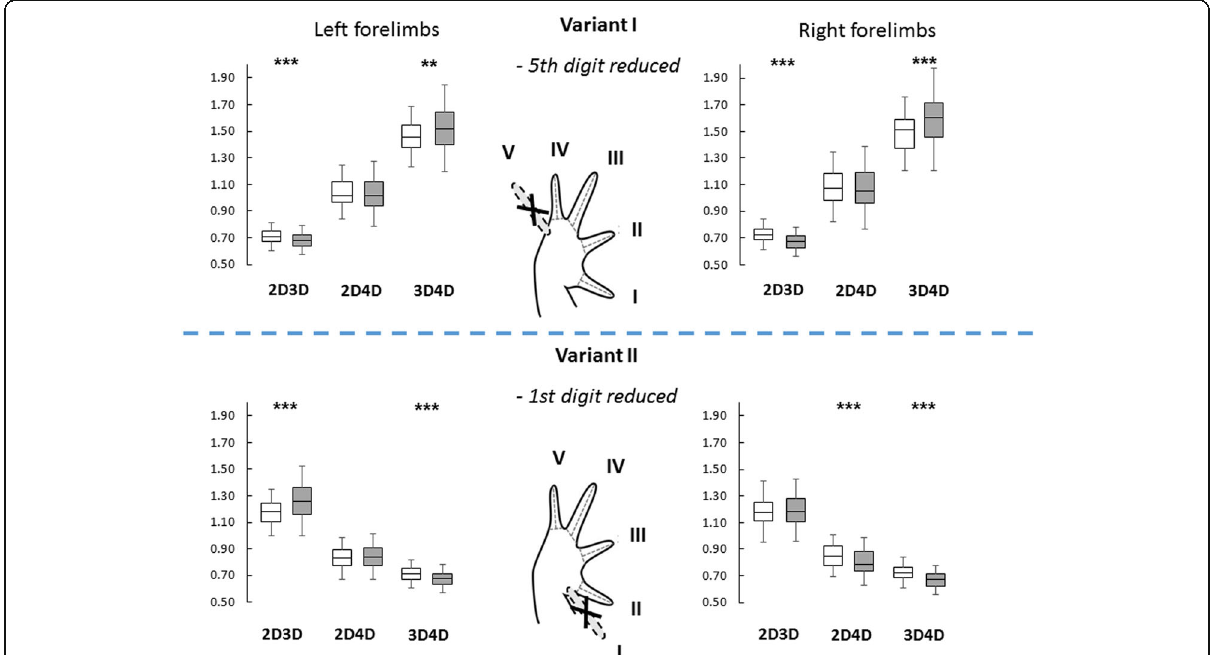
Fig. 1 Two alternative finger numbering protocols for anuran forelimbs, reflecting the hypotheses that the fifth (variant I) or the first (variant II) digit was reduced during phylogenesis. The upper and lower parts of the figure show which fingers are used to measure digit ratios in each of the adopted protocols, with the results presented in the form of box plots. It should be noted that 2D:3D in variant I corresponds to 3D:4D in variant II; similarly, 2D:4D corresponds to 3D:5D, and 3D:4D corresponds to 4D:5D. Although variant I is predominantly used in research, it is variant II that probably reflects the actual finger numbering in anurans (see in text: Limb and finger development in anurans). Asterisks indicate the statistical significance level of the difference in digit ratios between sexes (gray box plots - male; white box plots – female; levels of significance: *** p < 0.001, ** p < 0.01). The illustration of an anuran forelimb was adapted from